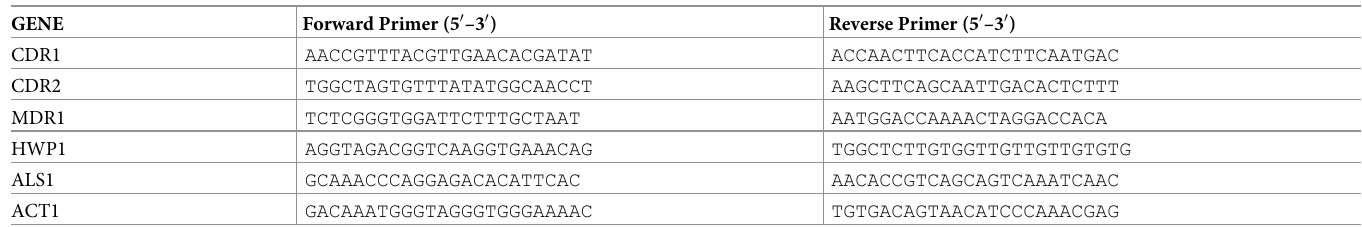
Table 1. RT-PCR primers.